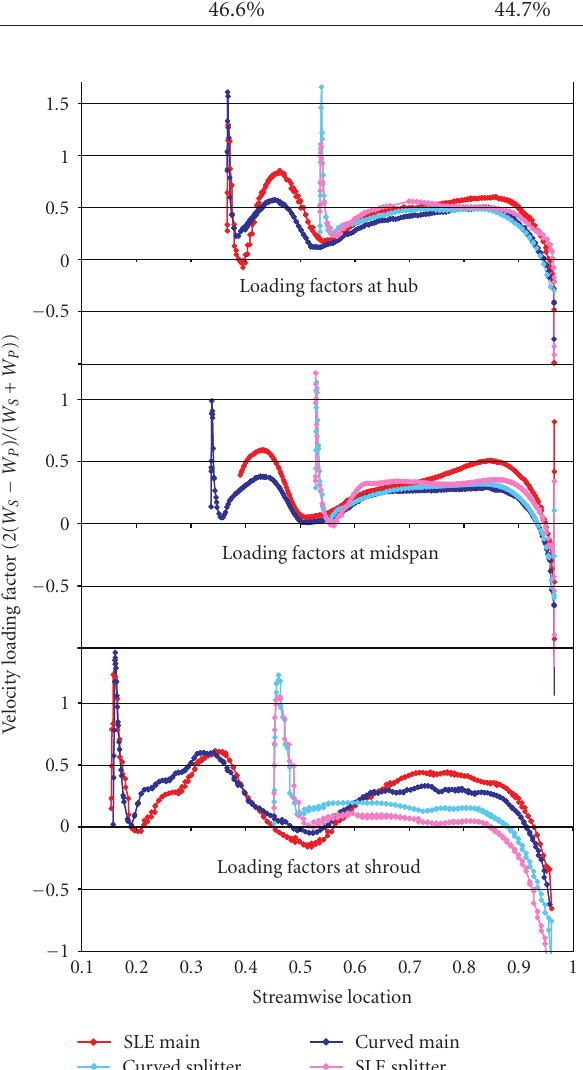
Figure 6: Loading factors (W S —velocity at suction side, W P — velocity at pressure side) at flow factor of